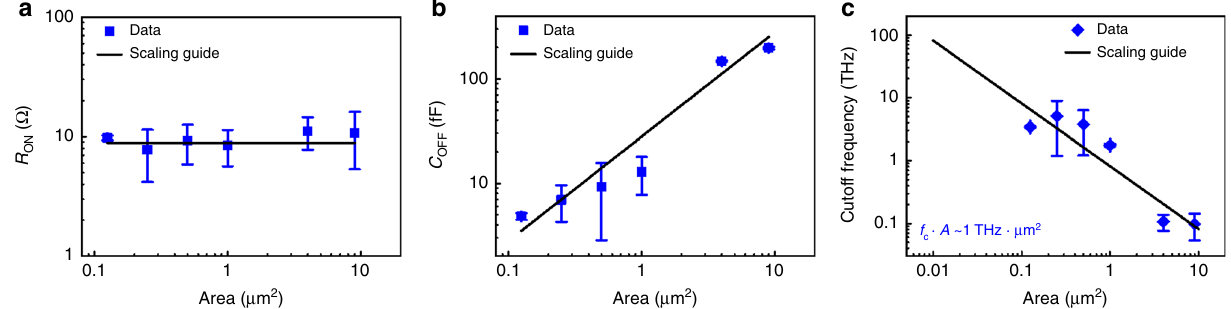
Fig. 4 Device scaling performance of the RF switches based on MoS 2 atomristor. The equivalent lumped element model parameters: a ON-state resistance, b OFF-state capacitance, and c cutoff frequency dependencies on the area. The error bar indicates the standard deviation. The normalized fi gure of merit, f c ∙ A ~ 1 THz- μ m 2 . While the ON-state resistance is area independent, the OFF-state capacitance is dependent on the lateral area of the device and has a normalized capacitance of ~28 fF/ μ m 2 . The lines in the fi gures are area-scaling guides and the slopes of b , c are based on the statistically